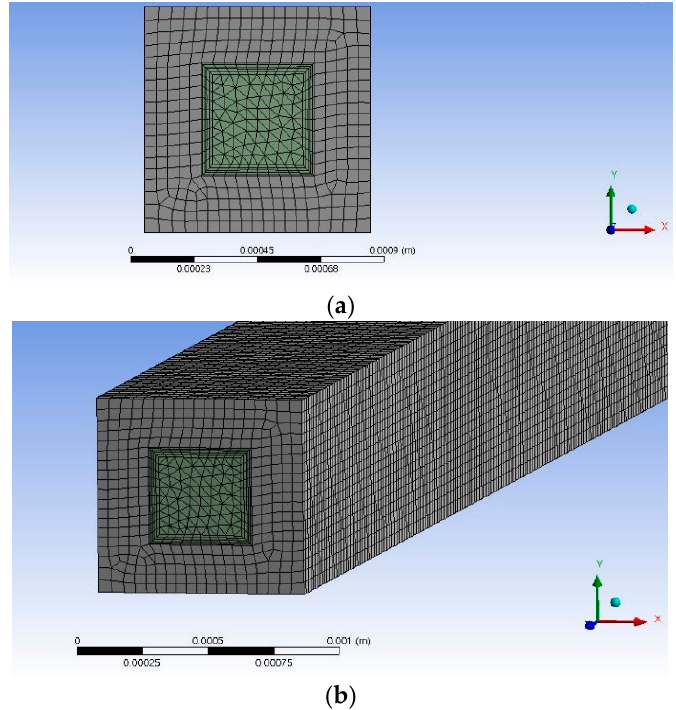
Figure 4. Capillary tube mesh: ( a ) Section 1; ( b ) Section 2.